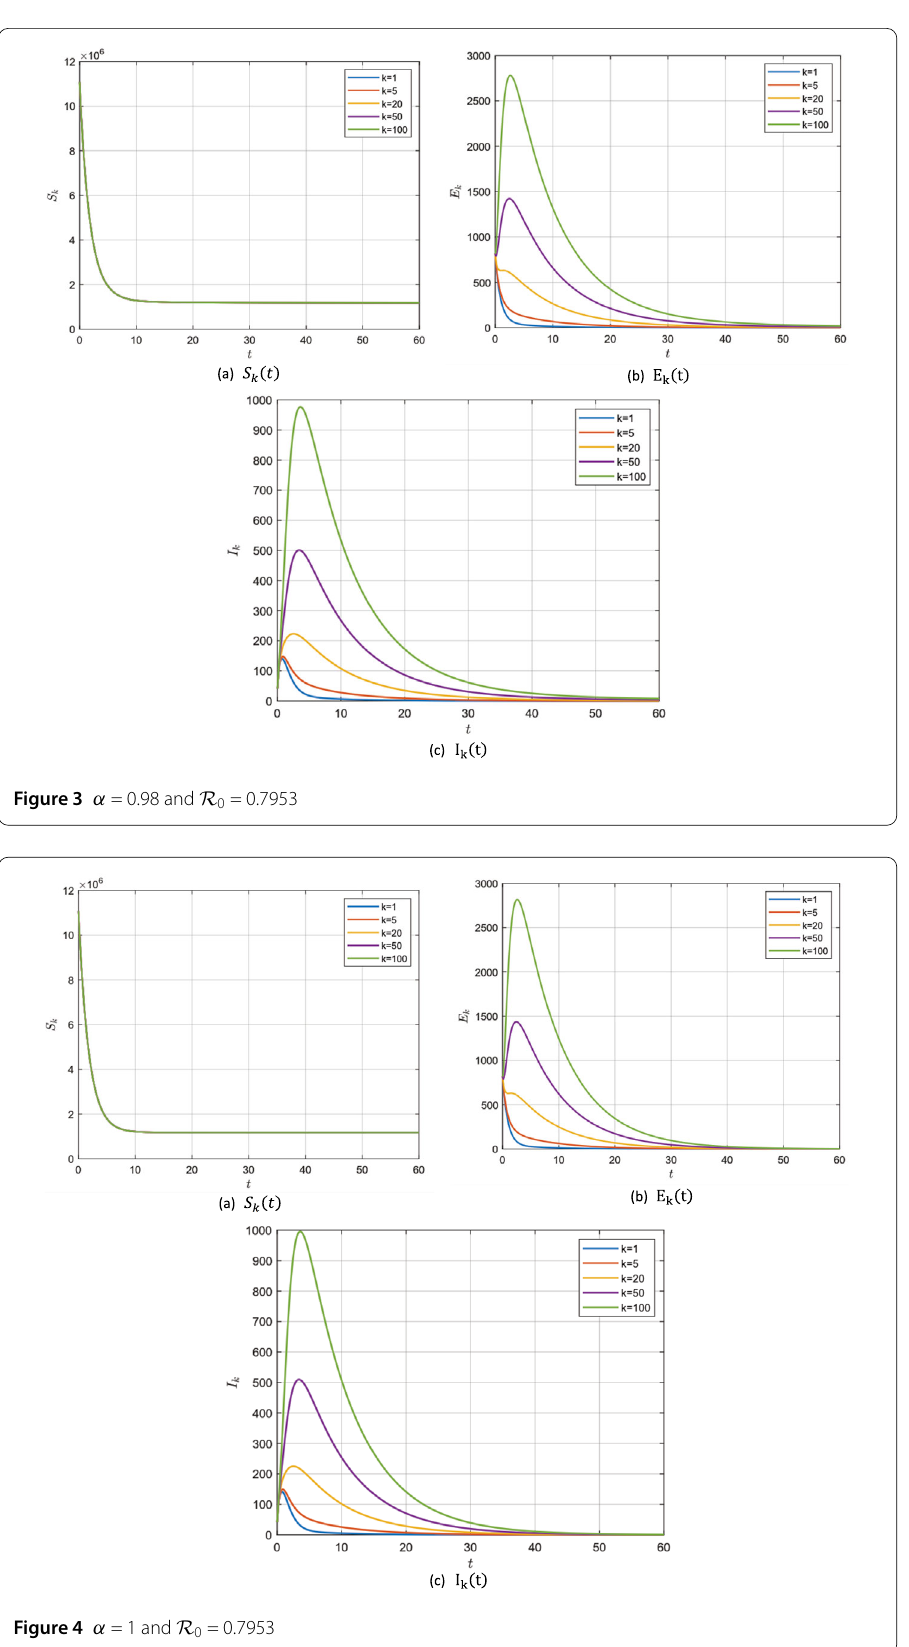
Figure 4 α = 1 and R 0 =